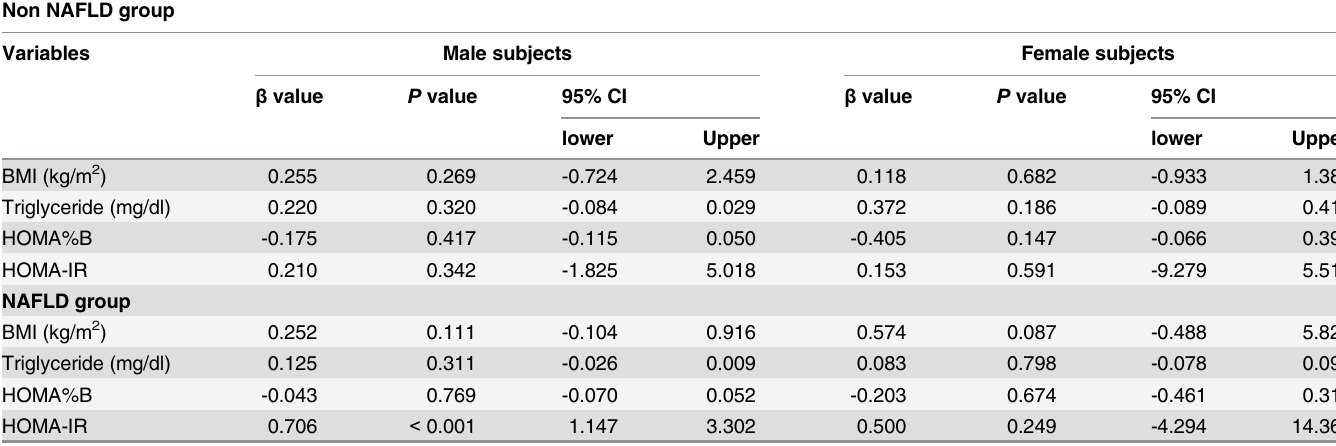
Table 4. Multiple linear regression analysis using log leptin as the dependent variable in both